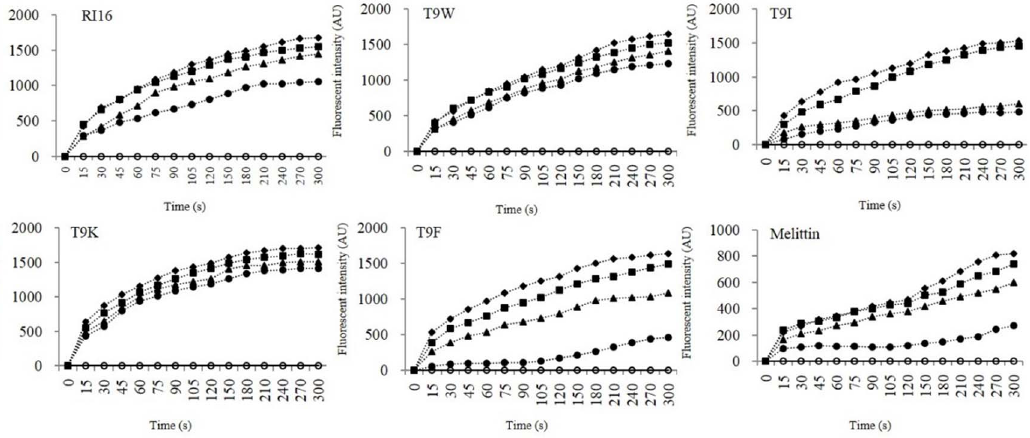
Fig. 4. The cytoplasmic membrane potential variation of P. aeruginosa 27853 treated by peptides at concentrations of 0 (open circles), 0.8 (solid circles), 1.6 (triangles), 3.2 (squares), and 6.4 (rhombus) m M, as assessed by release of the membrane potential-sensitive dye diSC 3 -5. The fluorescent intensity was monitored at an excitation wavelength of 622 nm and an emission wavelength of 670 nm as a function of